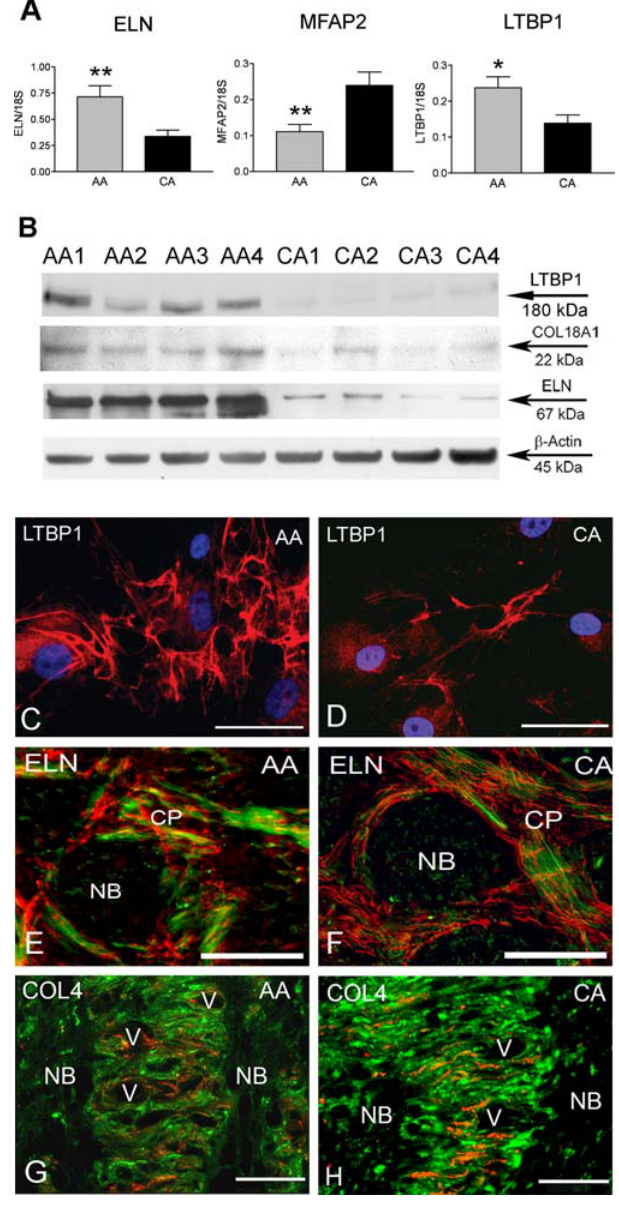
Figure 5. Differential expression of genes associated with the extracellular matrix (ECM) in AA astrocytes compared to CA astrocytes. A. Confirmation of three differentially expressed adhesion genes by qRT-PCR in human normal ONH astrocytes: Elastin (ELN), microfibrillar-associated protein 2 (MFAP2) and latent transforming growth factor beta binding protein 1 (LTBP1). Genes were normalized to 18S. Graphical representation of the relative mRNA levels in normal AA and CA astrocytes (n=8, respectively, two-tailed t-test was used. ** indicates p , 0.01 and * indicate p , 0.05). B. Representative Western blots of astrocyte cell lysates with LTBP1, ELN and collagen type XVIII antibodies. b -actin was used as a loading control. Note that AA1-4 donors express more LTBP1, ELN and collagen type XVIII than CA1-4 donors. C, D. Immunocytochemistry of LTBP1 in AA and CA astrocytes. LTBP1 (red) is more abundant in the cytoplasm and extracellular space in AA astrocytes compared with CA astrocytes. Nuclei stained with DAPI (blue). Magnification Bar: 25 m m. E, F. Double immunostaining of ELN (red) and GFAP (green) in representative cross sectional of the ONH tissue in AA and CA donors. ELN is located in the cribriform plates and not in the nerve bundles. Astrocytes cell bodies are located in the cribriform plates (CP) and extend processes into the nerve bundle